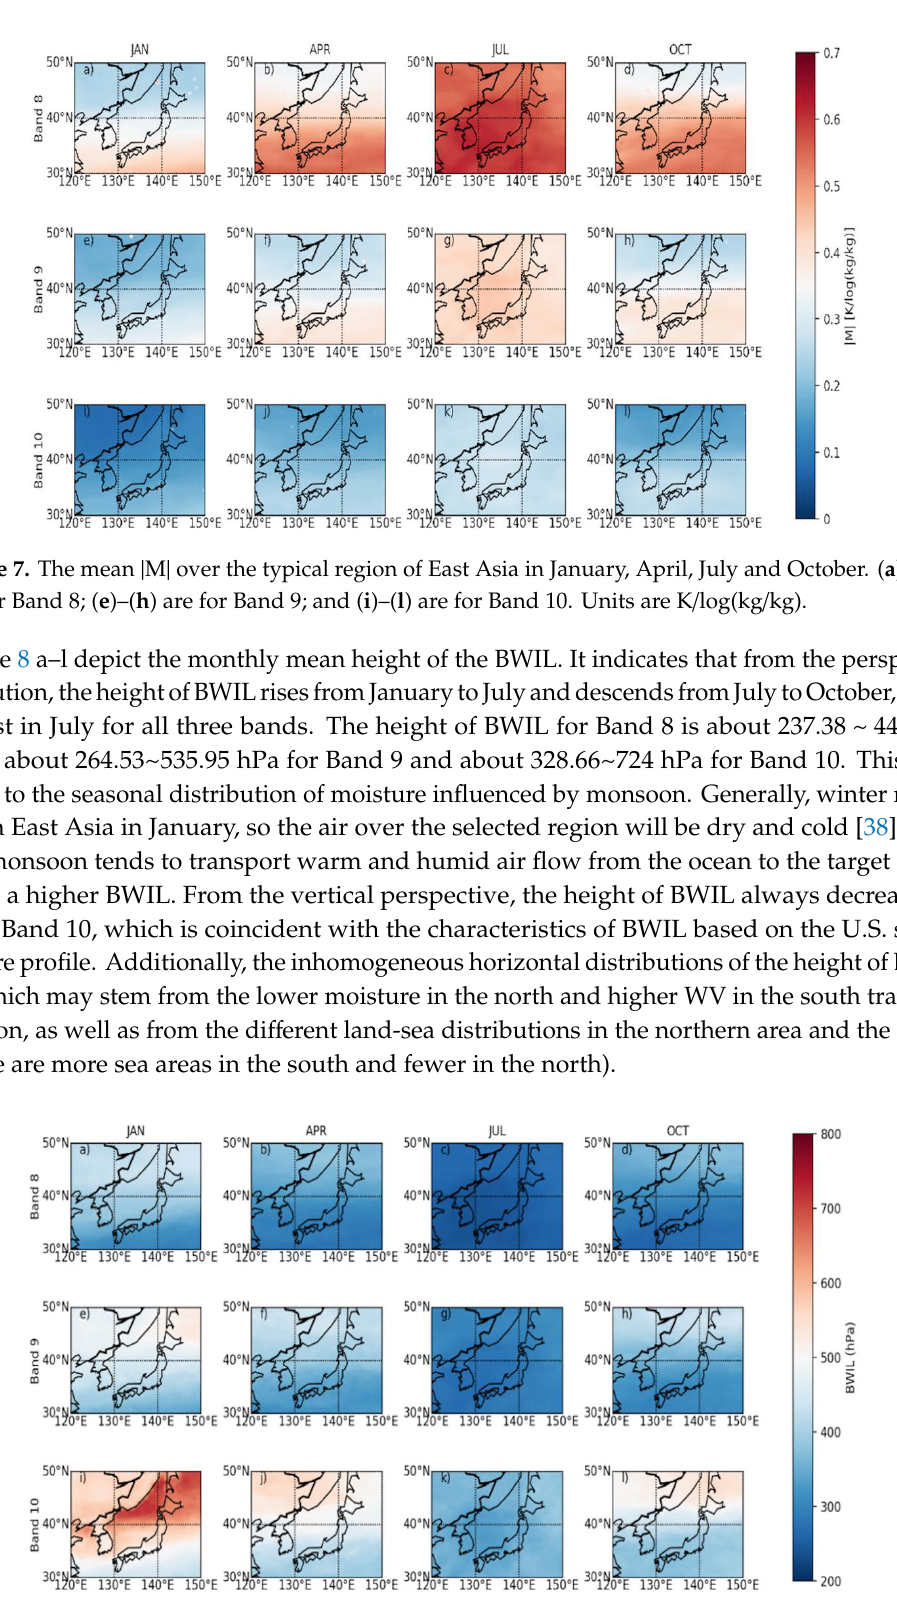
Figure 8. The mean height of BWIL over the typical region of East Asia in January, April, July and October. ( a )–( d ) are for Band 8; ( e )–( h ) are for Band 9; and ( i )–( l ) are for Band 10. Units are hPa.